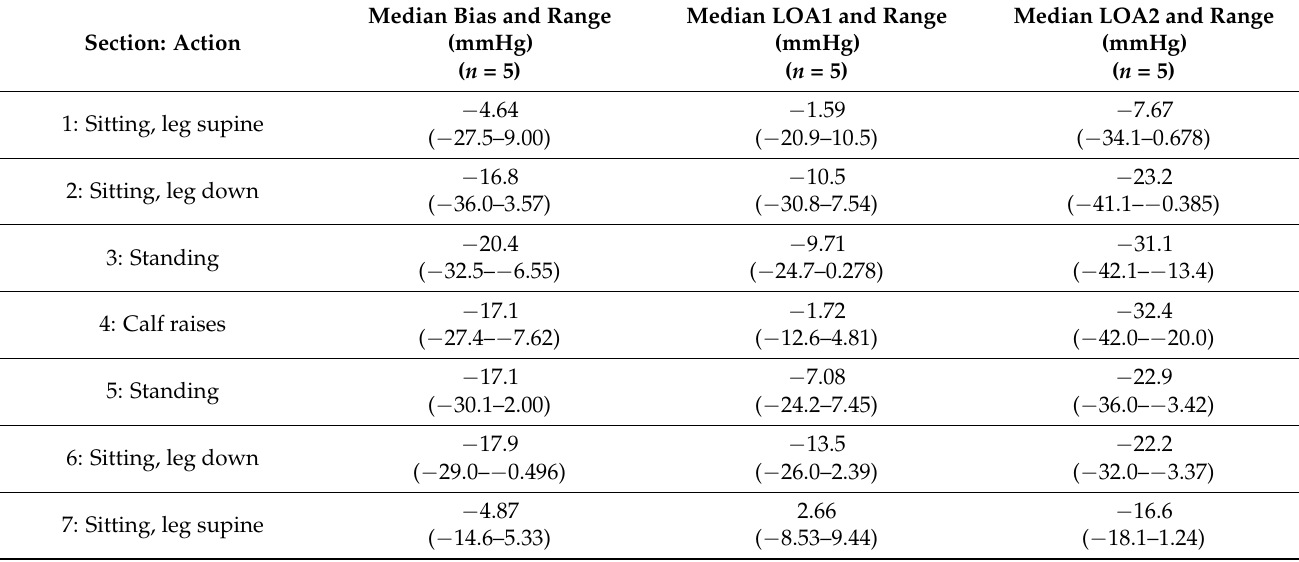
Table 2. Data from the five wraps directly comparing the FOPS to the PicoPress. Each wrap was bro- ken down into sections based on the seven different movements performed (as shown in Figure 11) and a Bland–Altman plot was produced from each of these sections. Each of the Bias values is therefore the median of five different Bland–Altman plots. LOA–limit of agreement between Pico- Press and FOPS. LOA1 is the upper limit and LOA2 is the lower limits of agreement i.e., 1.96 × standard